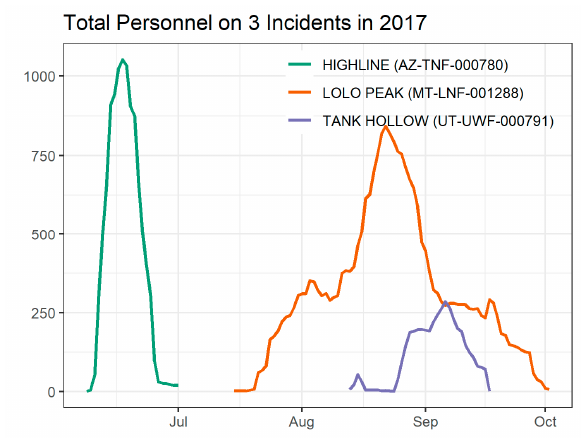
Figure 1. Total personnel assigned and expected to be at the fire camp (e.g., non-aerial resources) for three large incidents over time; data are from the Resource Ordering and Status System.